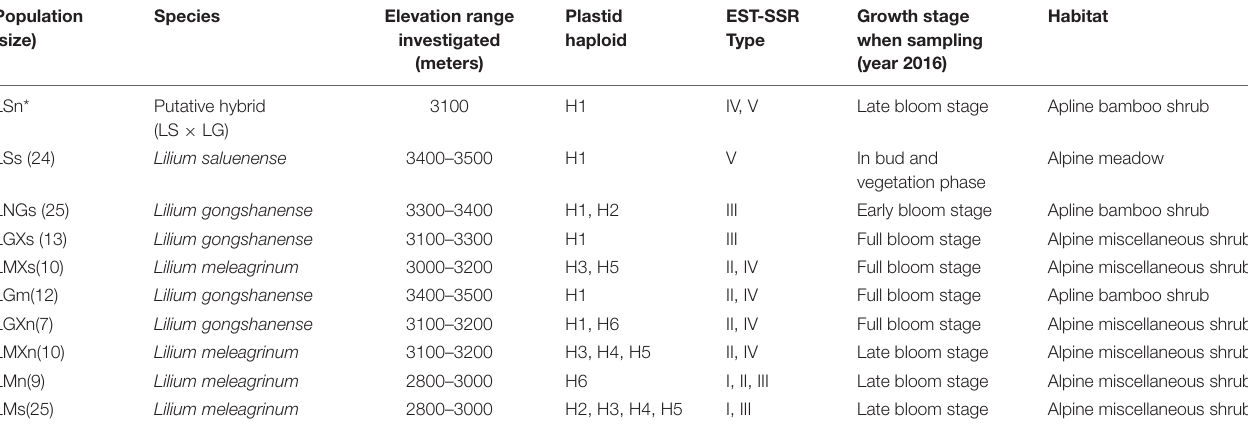
TABLE 1 | General information of species and population composition of hybrid zone under